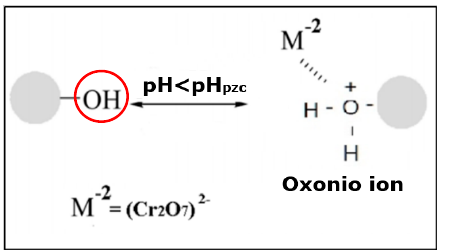
Figure 5. Cr (VI) adsorption mechanism with CP surface proposed by authors.